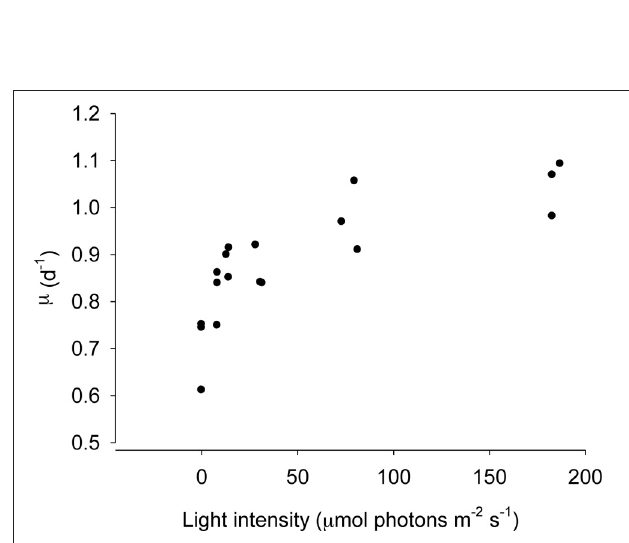
FIGURE 2 | Numerical response curves for Strombidium rassoulzadegani cultured on the chlorophyte PLY429 and transferred to a diet of PLY429, the cryptophyte Rhodomonas lens (RHODO) or a mixture of the two. Curves are fit to the Michaelis-Menten function µ = µ max [C − t]/(K + [C − t]), where µ is per capita growth rate, C is food concentration, K is the half-saturation constant, and t is a threshold below which growth is < 0. For all three diets in this case, thresholds were not distinguishable from zero. The RHODO-only diet had a higher K than PLY-only or the mixed diet. In this case, the mixed diet appeared to give a higher maximum growth rate than either sole diet.